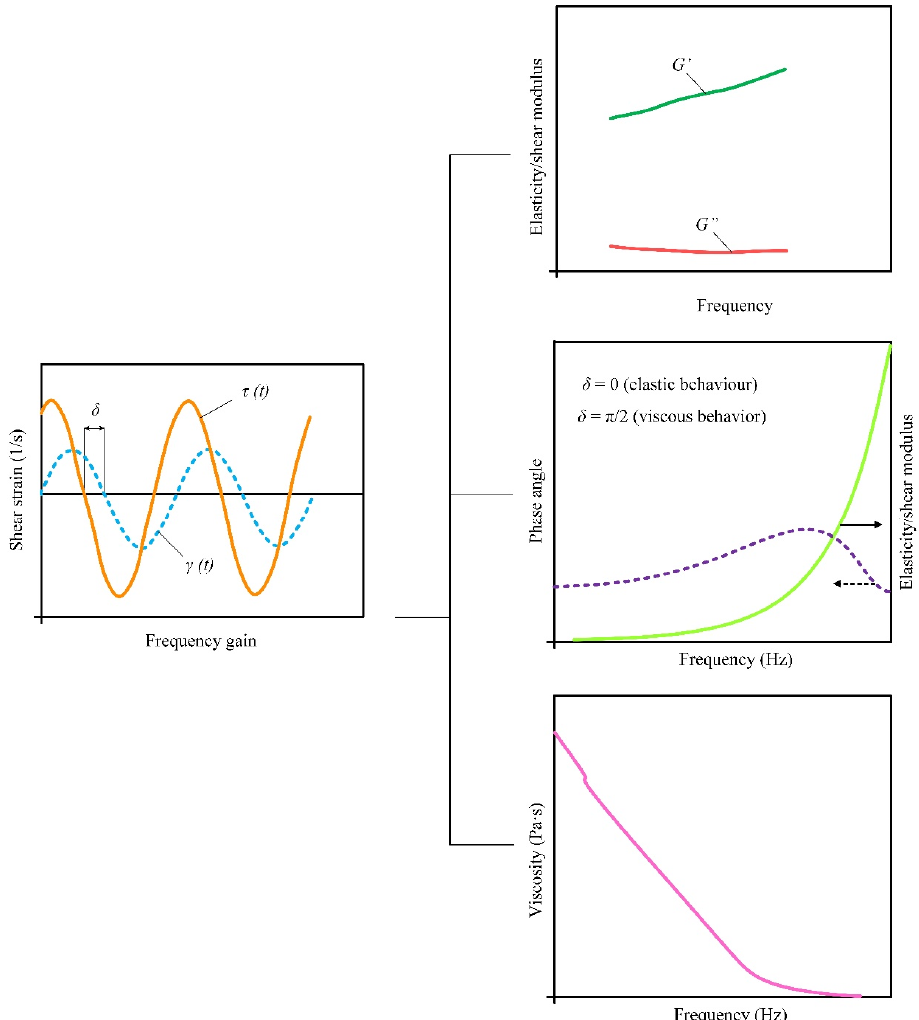
Figure 7. Typical trends obtained in the study of gel fuel for oscillatory shear [126,138]. The authors of [109] proposed a technique for studying the characteristics of elastic deformation of oil-filled cryogels based on 5% and 10% PVA aqueous solutions. It has been established that the higher the concentration of PVA in an aqueous solution and the lower the oil content in the fuel, the higher the elasticity of the pellets under otherwise identical conditions (Figure 8). The difference between the elastic modulus of pellets based on 5% and 10% PVA solutions with different oil concentrations is 27–71%. The results obtained qualitatively agree with the results in [139].